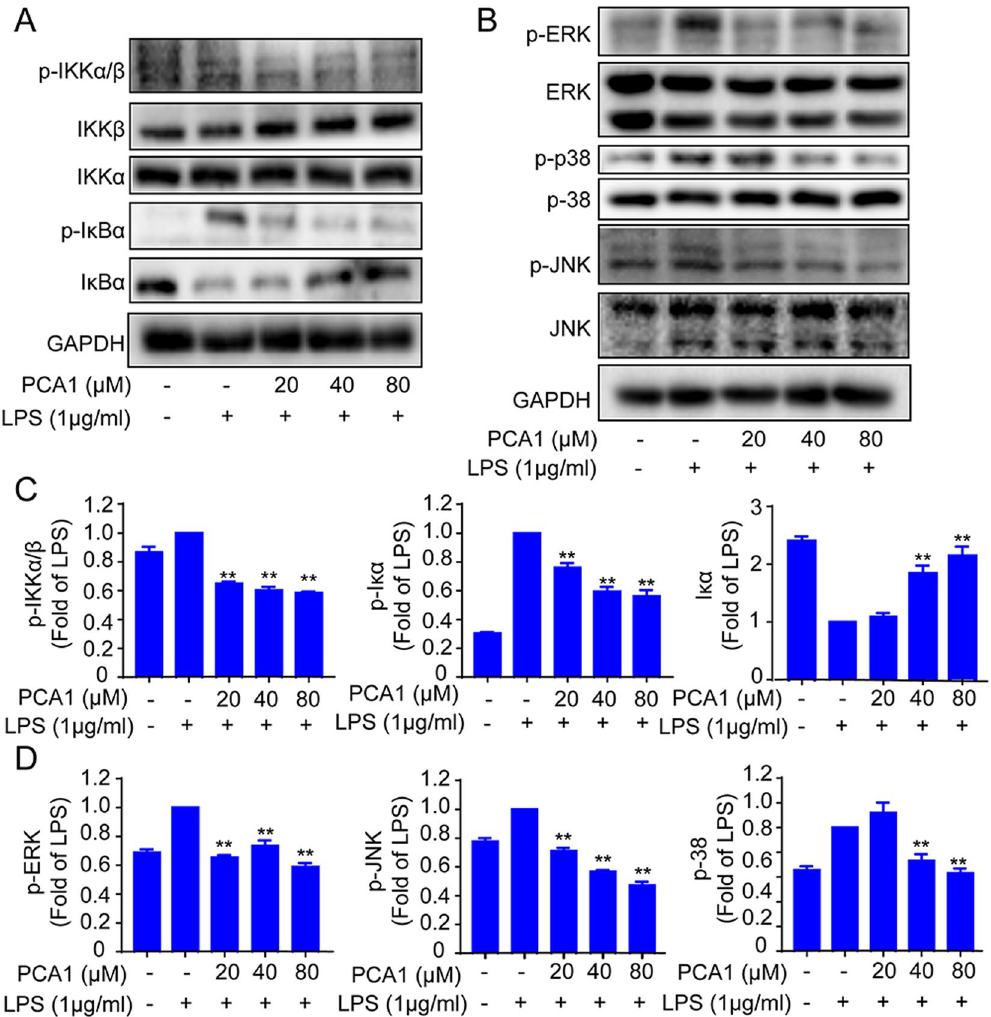
Figure 4. Impact of PCA1 on the NF- κ B and MAPK pathway in RAW264.7 cells. ( A , B ) RAW264.7 cells treated with PCA1 for 2 h were induced by LPS. The NF- κ B and MAPKs signaling pathway expression proteins were detected using Western blotting. ( C , D ) Statistical analysis of the I κ B- α , IKK- α / β , IKK- α , IKK- β , p-JNK1/2, JNK1/2, p-ERK1/2, ERK1/2, p-p38, and p38 per group. The grouping of gels/blots cropped from different parts of the same gel (targets vs loading control) or different gels (phosphorylation). The full blots are shown in Supplementary Information. * p < 0.05, ** p < 0.01, and *** p < 0.001 versus the LPS